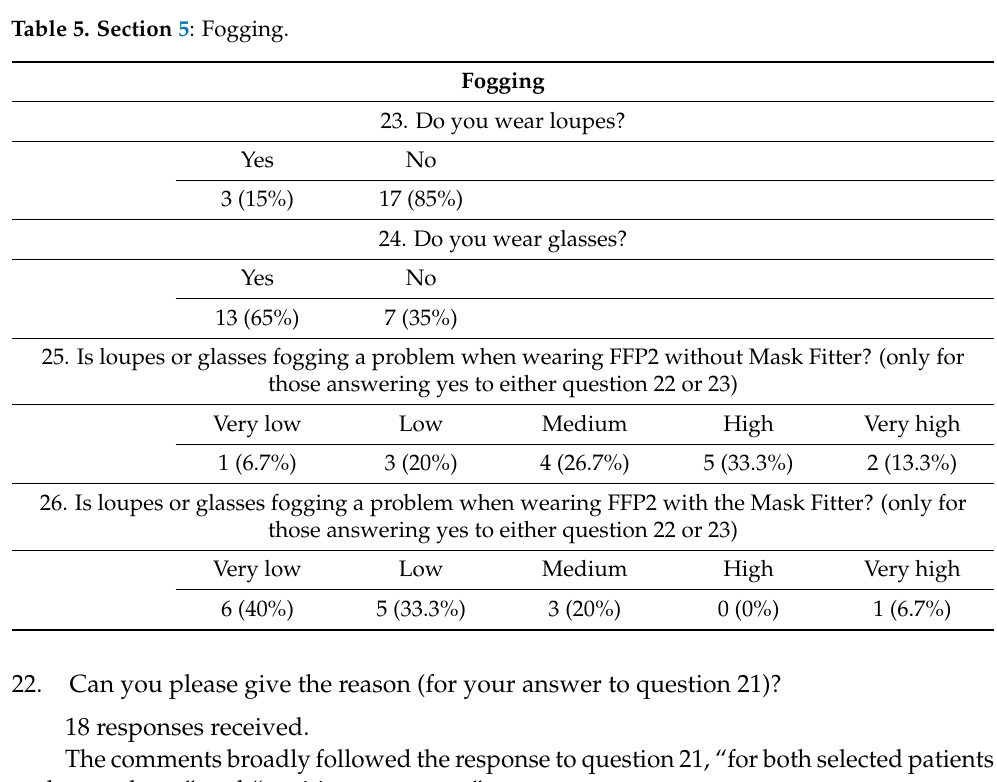
Table 5. Section 5 : Fogging.